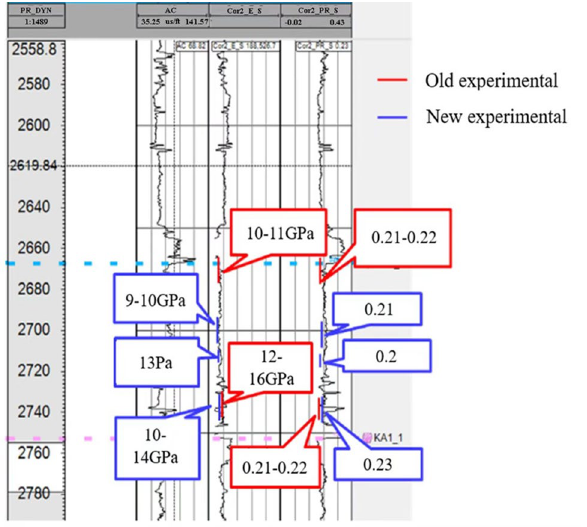
Fig. 9 Comparison of calculation results of static Young's modulus and Poisson's ratio with experimental static data in well